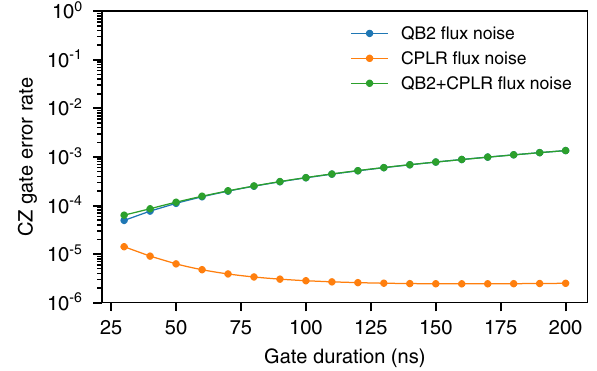
FIG. 36. Contribution of 1 =f α flux noise to error rates of CZ gates. Notably, the error contribution from CPLR flux noise increases as the gate duration decreases (orange circles), possibly due to stronger qubit-coupler hybridization.